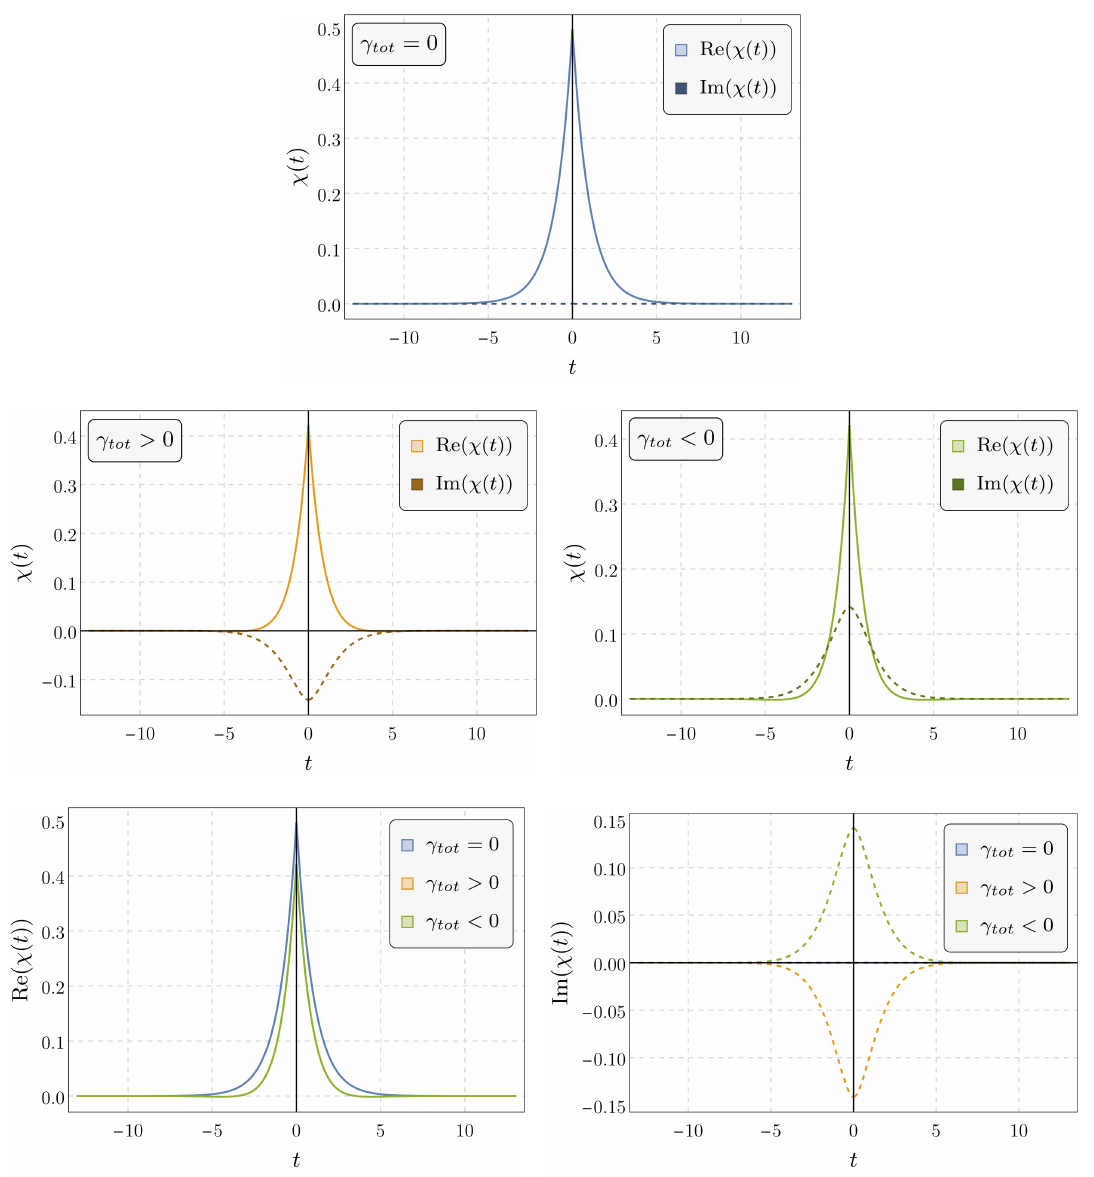
Figure 12 . Fourier modes of the propagator (function χ ( t ) in eq. (4.22)) in the case c gh = 1 , c th = − 1 , and E 2 < 0 , for various signs of γ tot ~q